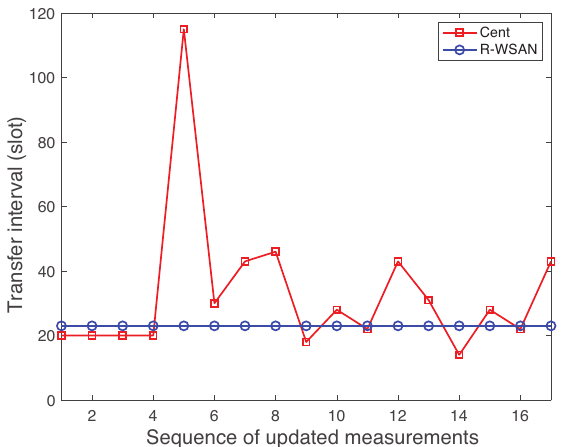
Figure 12. Measured transfer interval of plant 17 using R-WSAN and the centralized protocol as a function of sequence of updated measurements. The inter-cluster link is failed between global coordinator and cluster head 2.